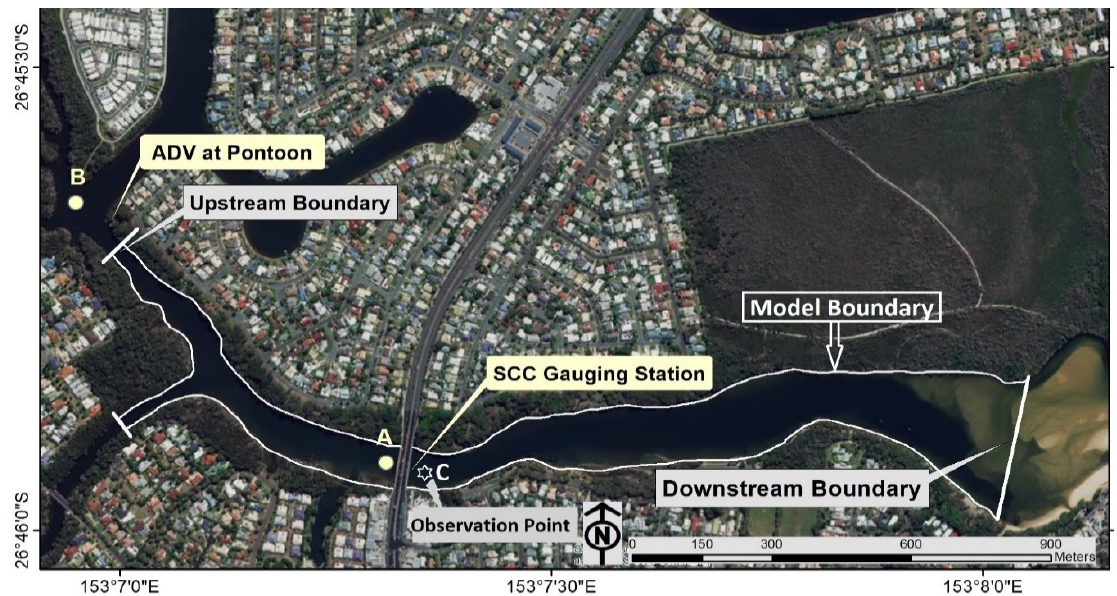
Figure 1. Aerial view of Currimundi Lake catchment, main channel including ADV and drifter’s deployment locations, model boundary, observation point (C) and tidal gauge station; (map is created using ArcGIS software by Esri). Drifters were deployed at point A and retrieved at point B.